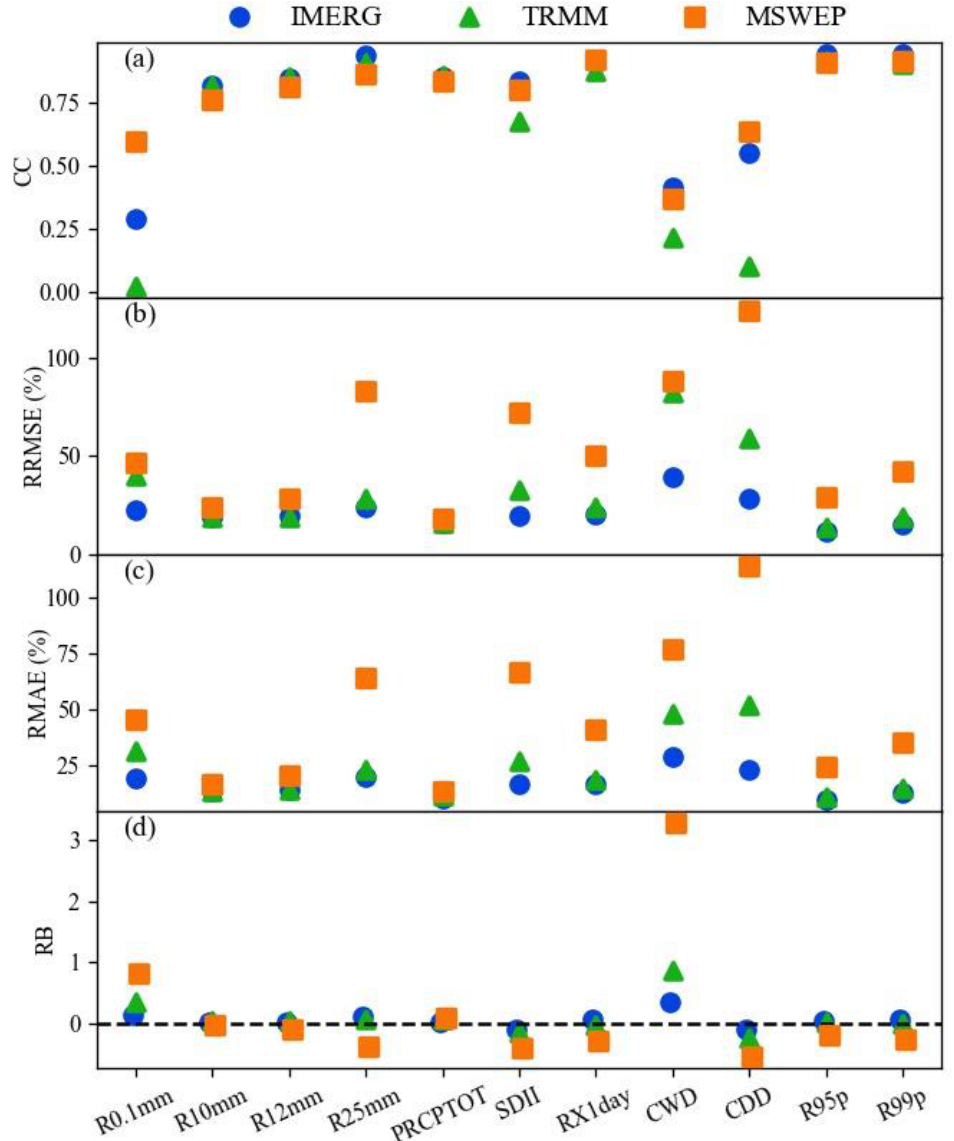
Figure 7. Distribution of continuous statistical metrics (( a ) CC, ( b ) RRMSE, ( c ) RMAE, and ( d ) RB) of the comparisons between the three precipitation products and ground observations at different extreme precipitation indices.